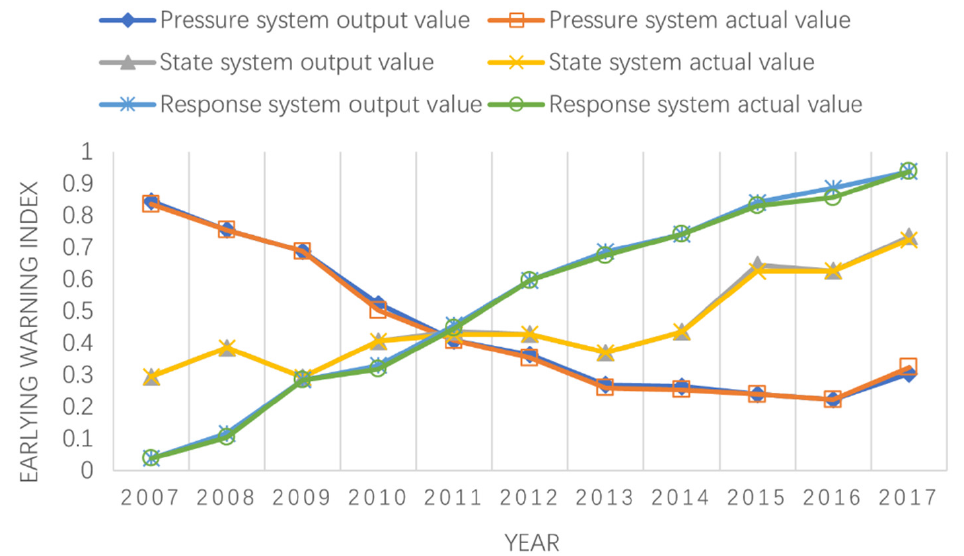
Figure 6. RBF study situation of each land ecological health early-warning subsystem in Henan Province.